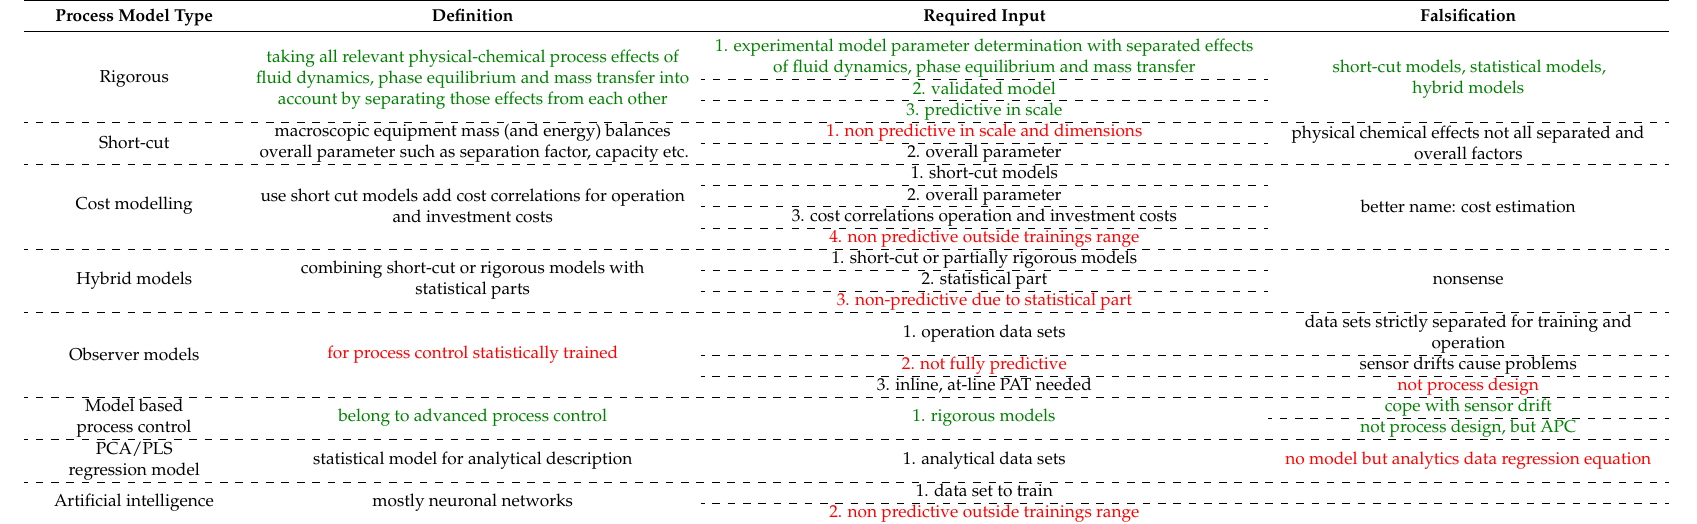
Table 1. Model types definition, required input and falsification from process engineering point of view (PCA: principal component analysis; PLS: partial least squares regression; APC: advanced process